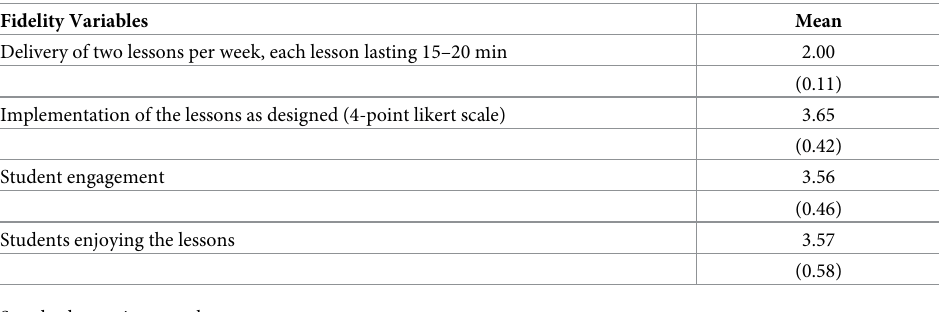
Table 2. Descriptive statistics for fidelity